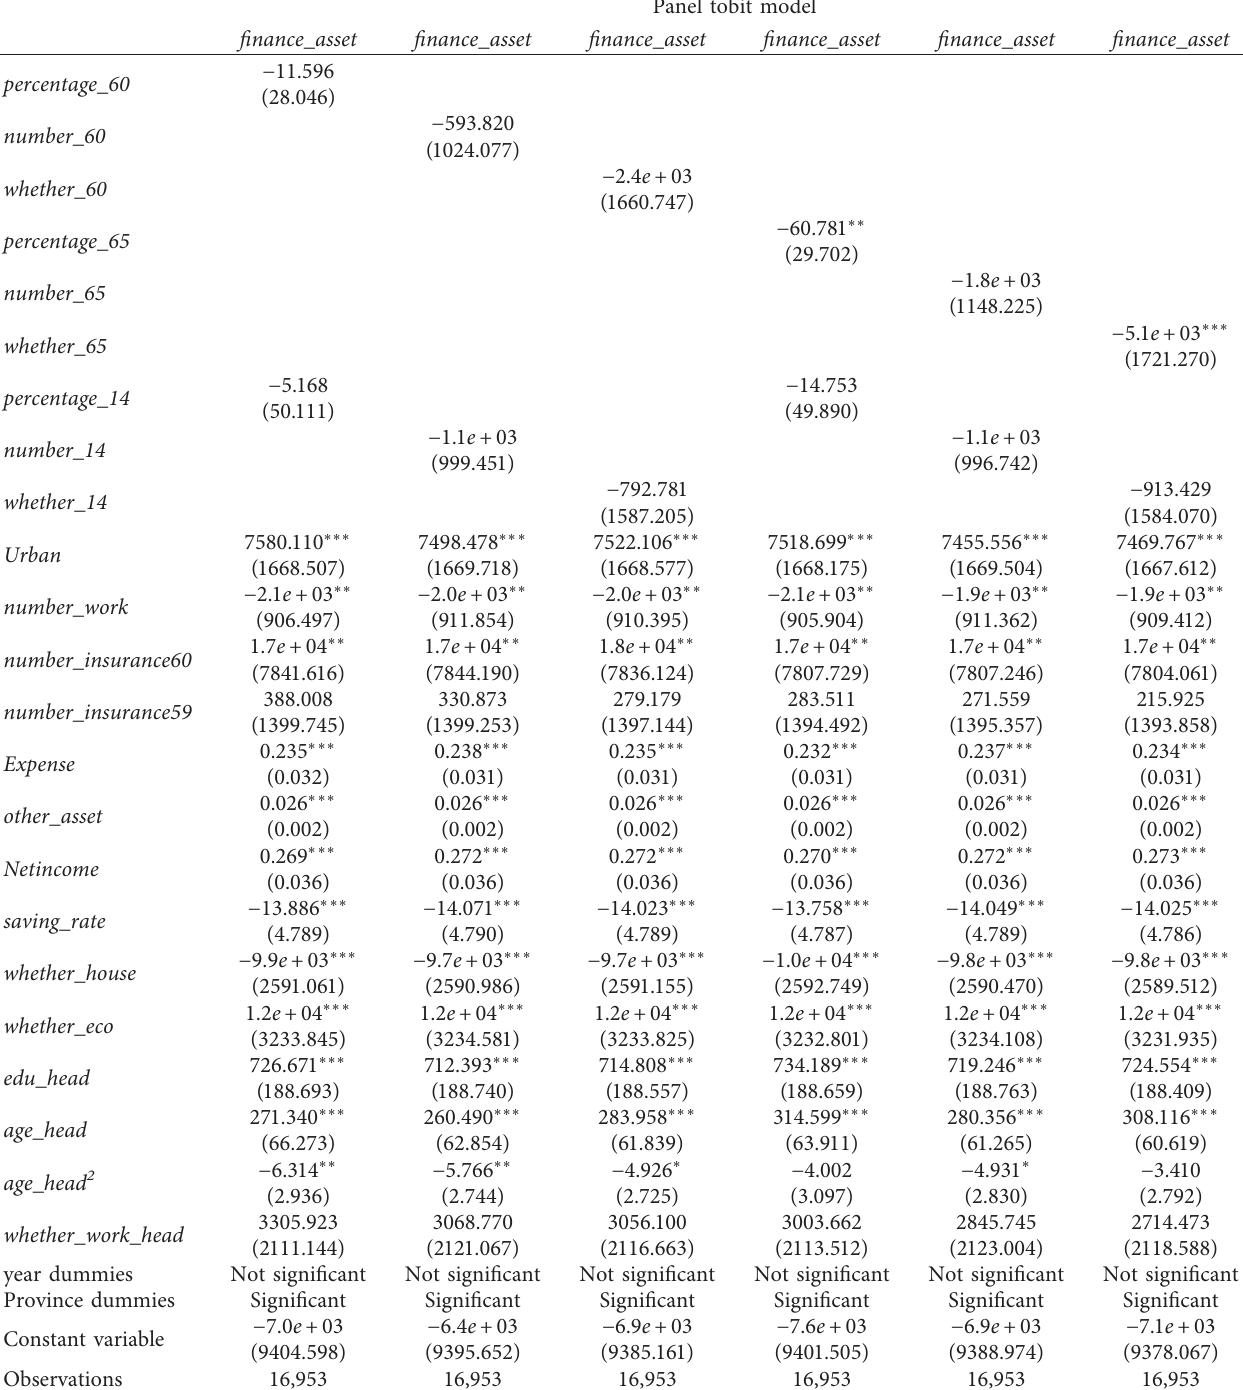
Table 3: Results on the scale of families’ financial